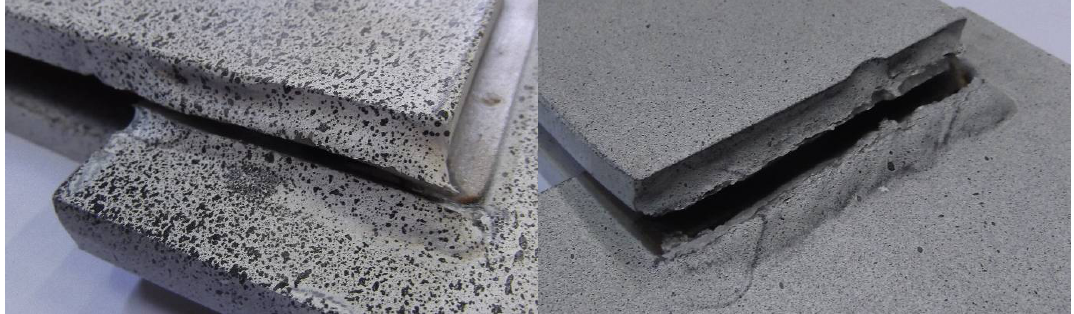
Figure 2. Typical failure mode for longitudinal welds ( left ) and transverse welds ( right